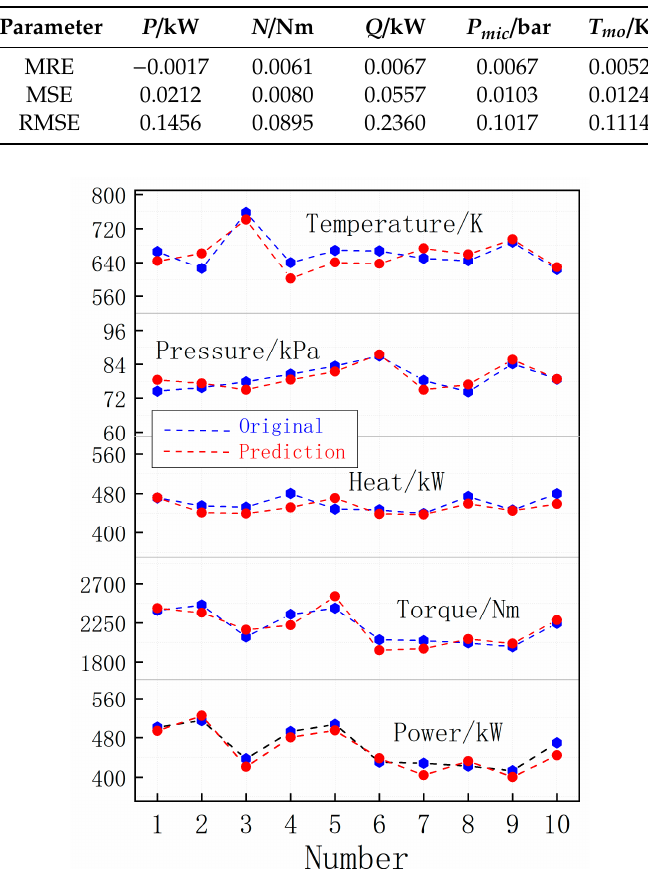
Figure 5. The comparison of original values with calculated ones in RBF-NN.